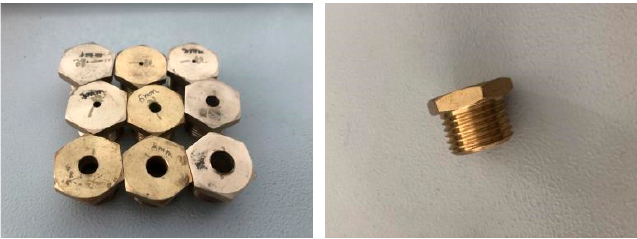
Figure 8. Diagram of the leakage point.